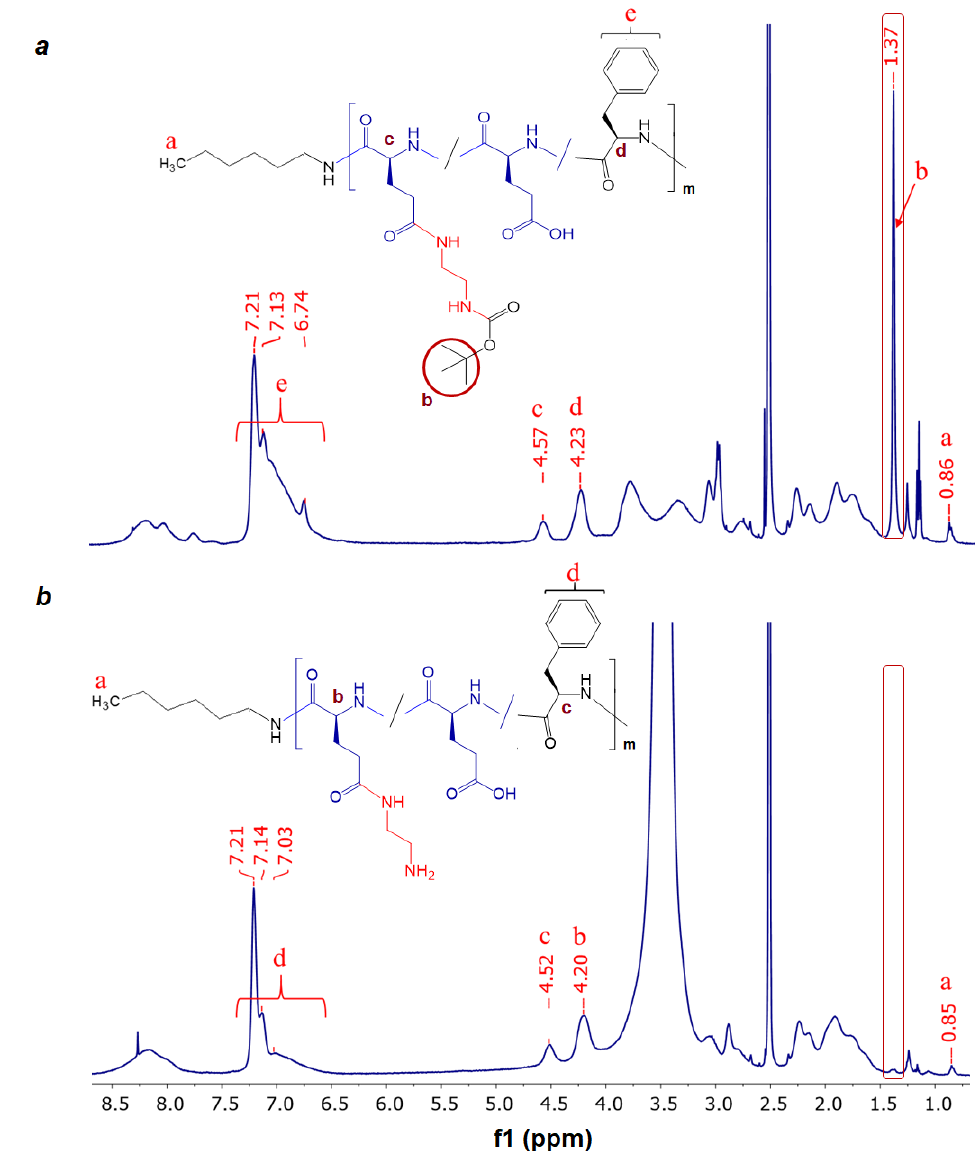
Figure 5. 1 H NMR spectra of P[EF]-EDA(BOC) ( a ) and P[EF]-EDA ( b ) (DMSO-d 6